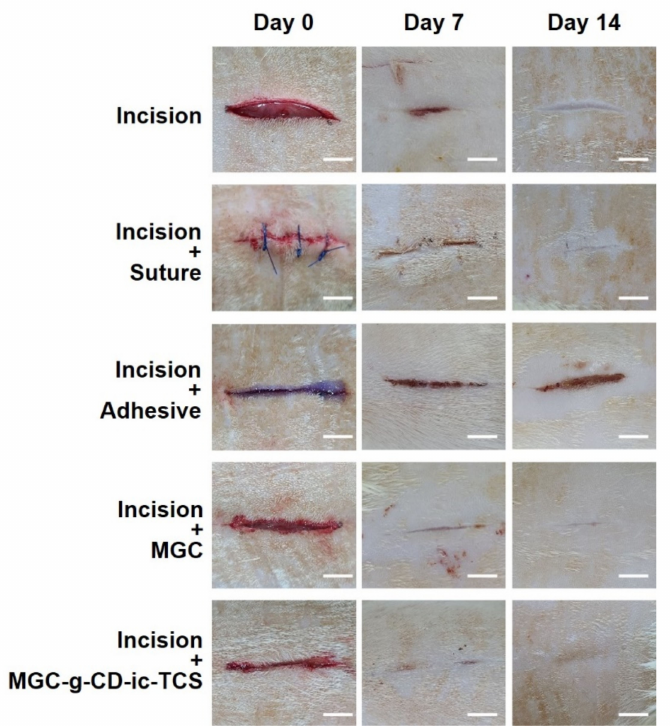
Figure 7. Gross appearances of untreated incision, and incisions treated with suture (incision + su- ture), cyanoacrylate (incision + adhesive), MGC (incision + MGC), and MGC-g-CD-ic-TCS (inci- sion + MGC-g-CD-ic-TCS). The incisions were observed at day 0, 7, and 14. The white scale bars indicate 1